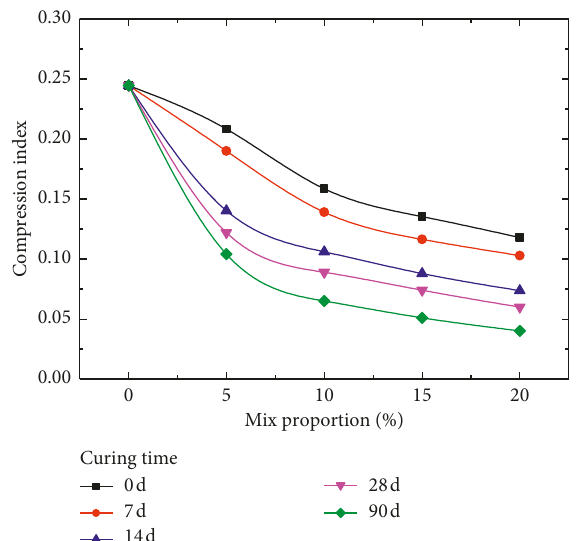
Figure 15: Compression index of expansive soil stabilized by RHA- Figure 16 for curing times of 0, 7, 14, 28, and 90 days.